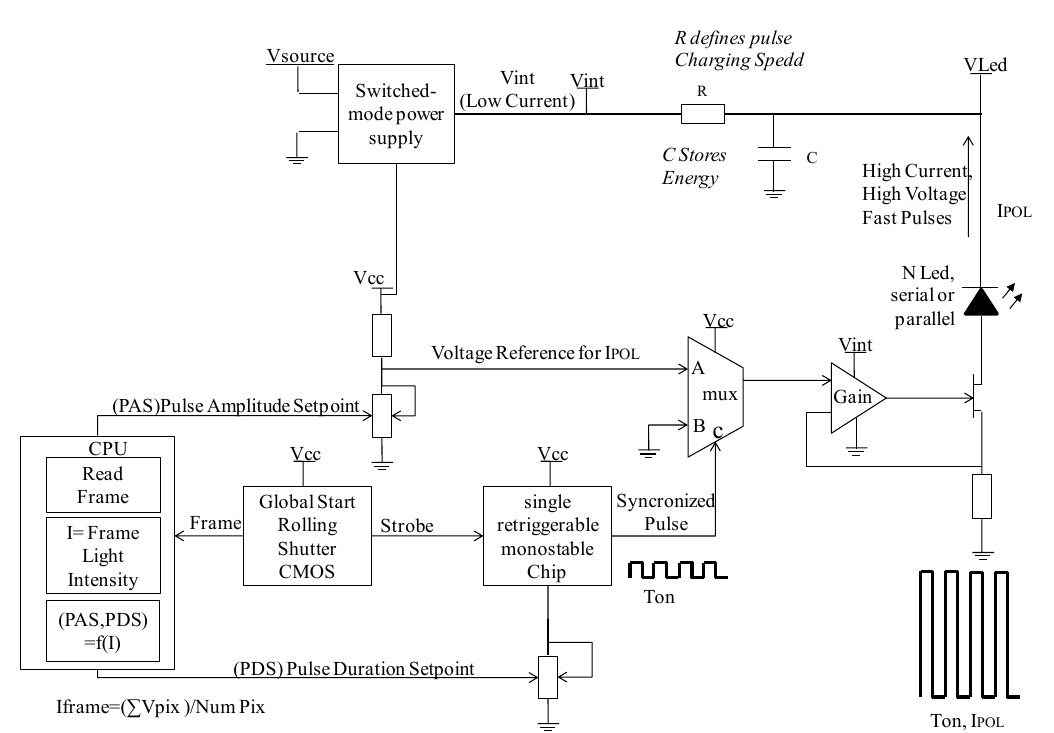
Figure 18. Block diagram of the stroboscopic light source of the sensor. Including the pulse length and amplitude control and the synchronization (strobe) control from the CMOS for triggering the pulse start.